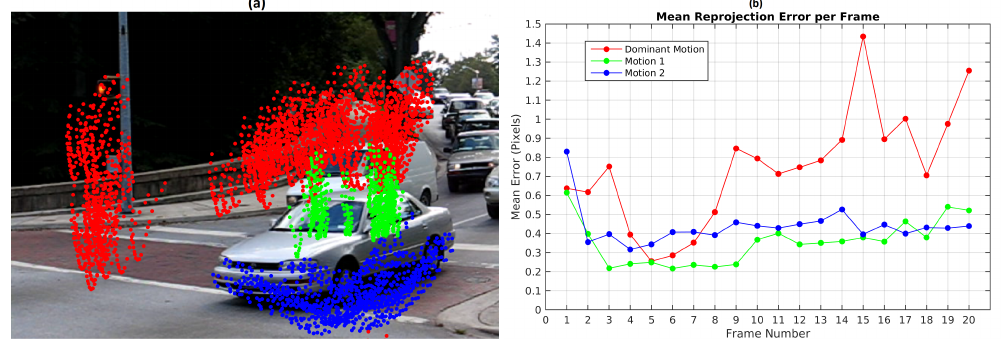
Figure 15. TbD-SfM results for Scene 4: ( a ) Motions segmented; ( b ) Mean reprojection error.